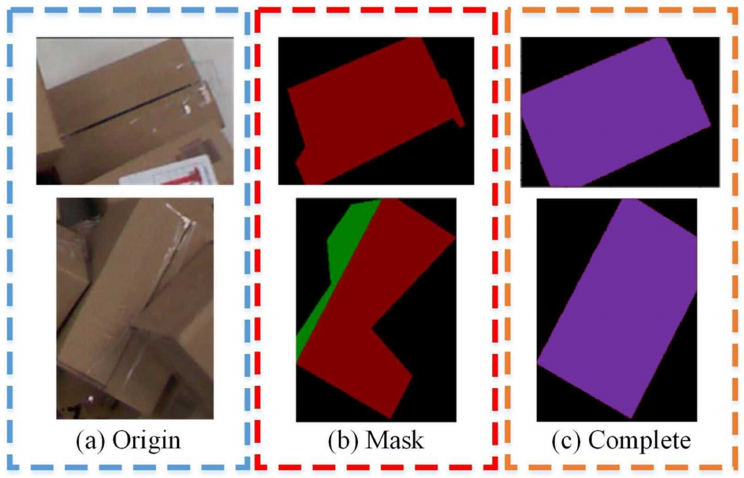
Figure 7. Sorting regions of different